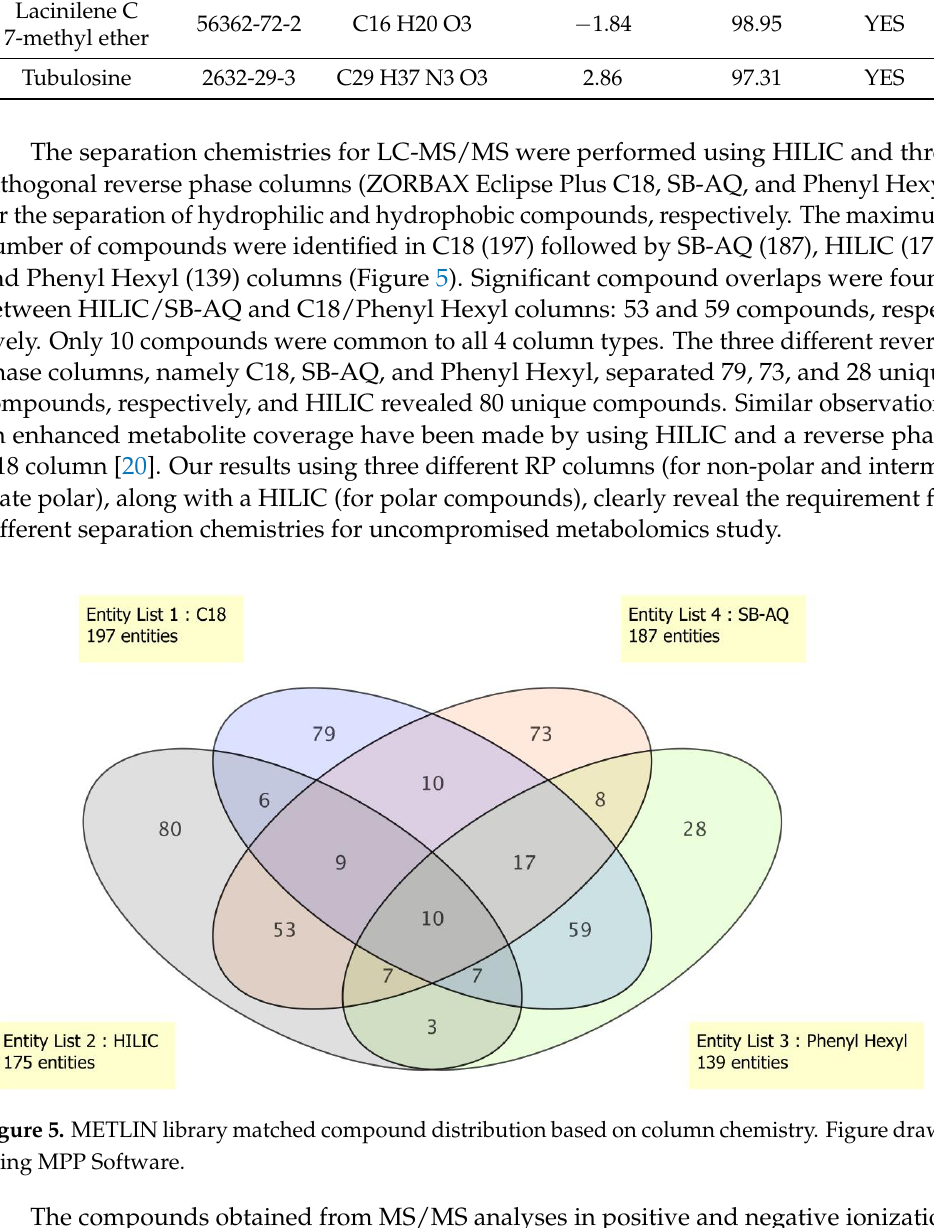
Figure 4. Proposed metabolite fragment structures for cephaeline based on MSC analysis. Table 4. Compounds found in Alangium species identified by Agilent MSC Software.